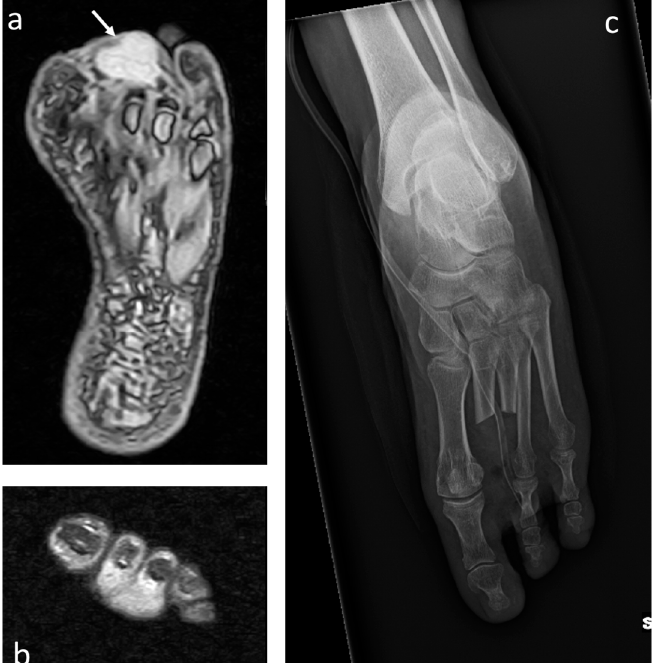
Figure 7. Clear-cell sarcoma of the foot (white arrows) in a 60-year-old female: ( a ) T2 STIR MRI showing the mass with increased signal intensity in axial and ( b ) coronal projection infiltrating the second and third finger. ( c ) Postoperative plain radiograph after double-ray amputation.